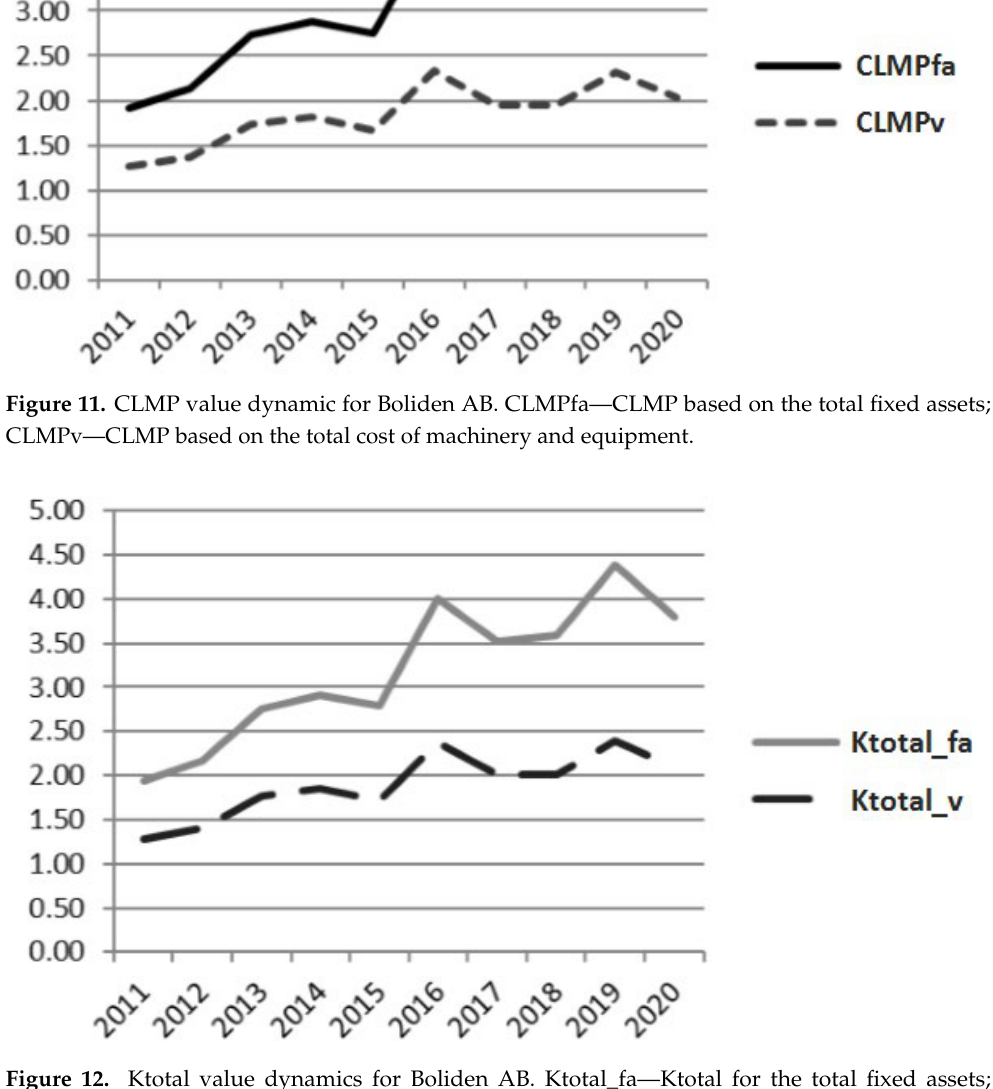
Figure 12. Ktotal value dynamics for Boliden AB. Ktotal_fa—Ktotal for the total fixed assets; Ktotal_v—Ktotal for the total cost of machinery and equipment. Ktotal_fa and Ktotal _v were calculated based on the initial fixed assets, intangible assets, and R&D costs.